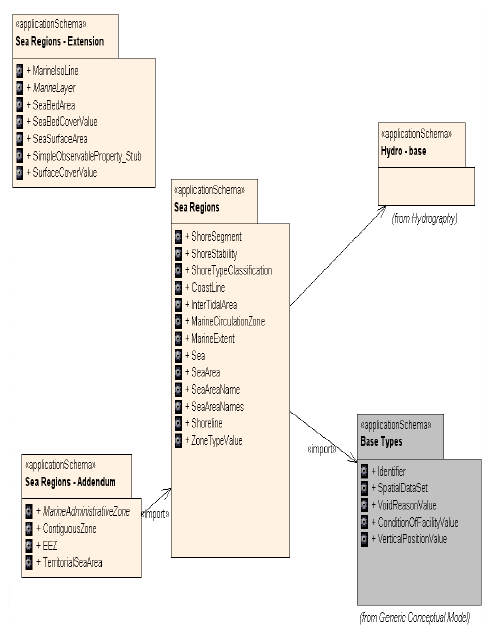
Figure 4. Marine related classes of INSPIRE [38].